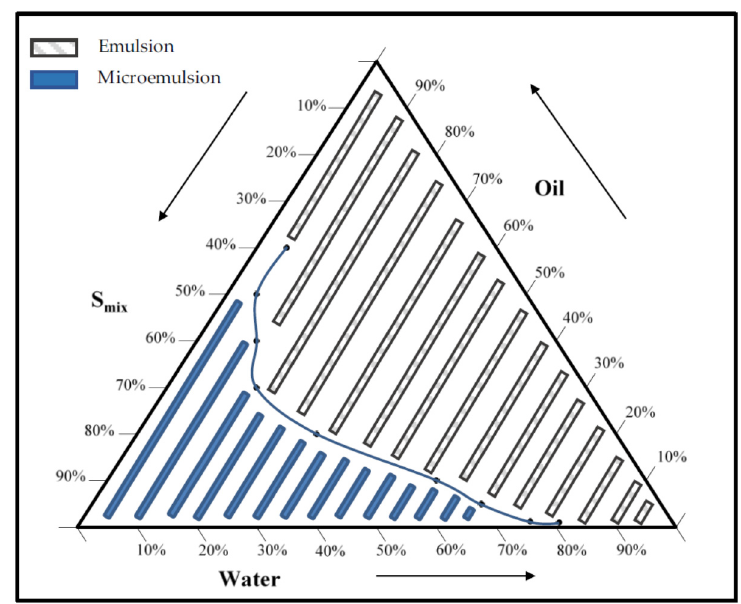
Figure 2. Pseudo-ternary phase diagram. The dark area represents the ME existence range and the Figure 2. Pseudo ‐ ternary phase diagram. The dark area represents the ME existence range and the grey area means crude emulsion range. grey area means crude emulsion range.